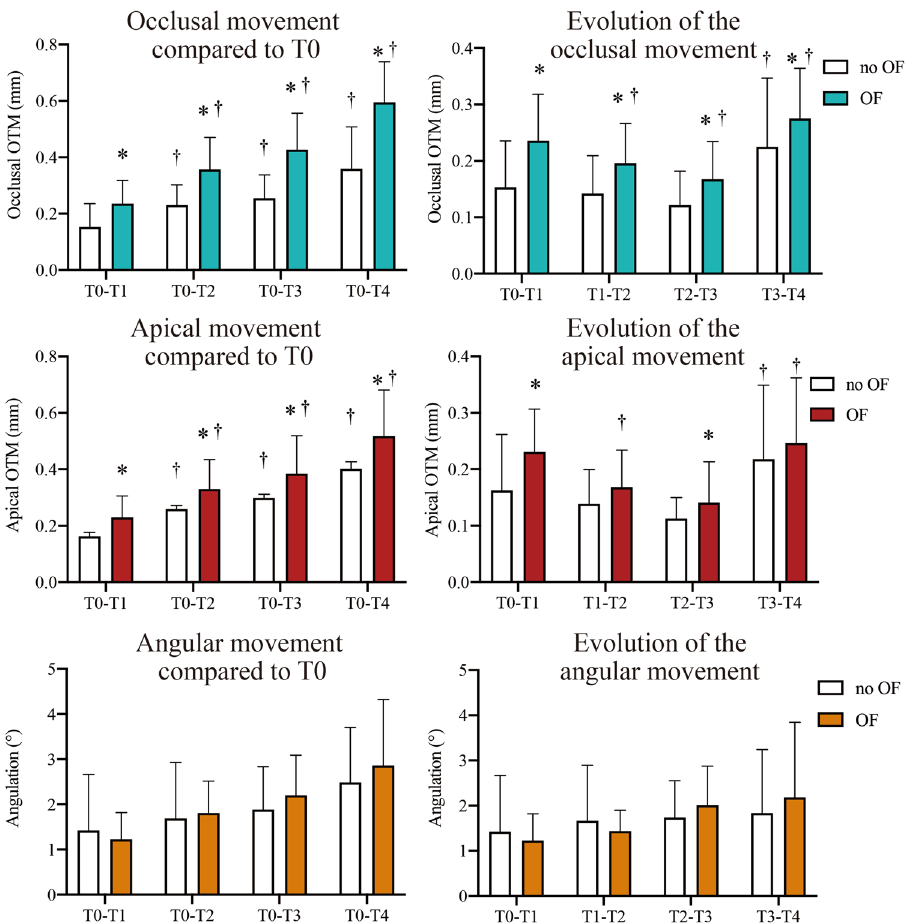
Figure 5. Second molar displacement. The OTM was compared between different time points (T0–T4) and between the OF and no OF side by two-way repeated measures MANOVA and post-hoc Tukey’s test (n = 12). * P < 0.01 versus no OF side. † P < 0.01 versus previous